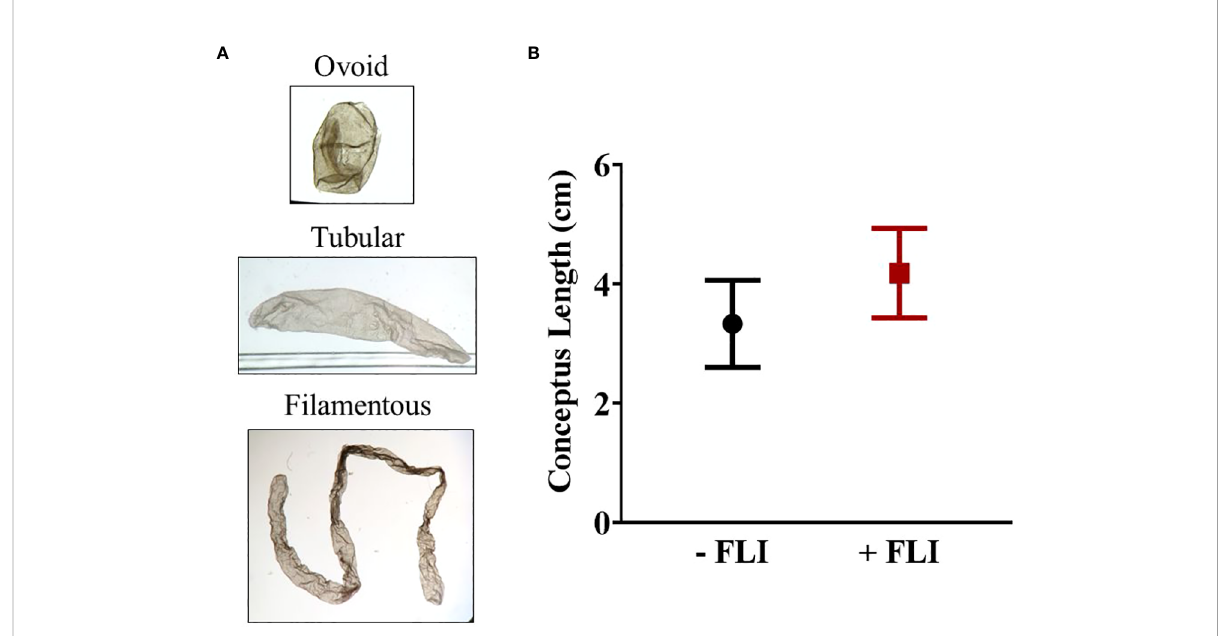
TABLE 3 Summary of the total transcript reads and aligned proportions to the bovine genome for embryos treated with or without FLI. Treatment Total Reads